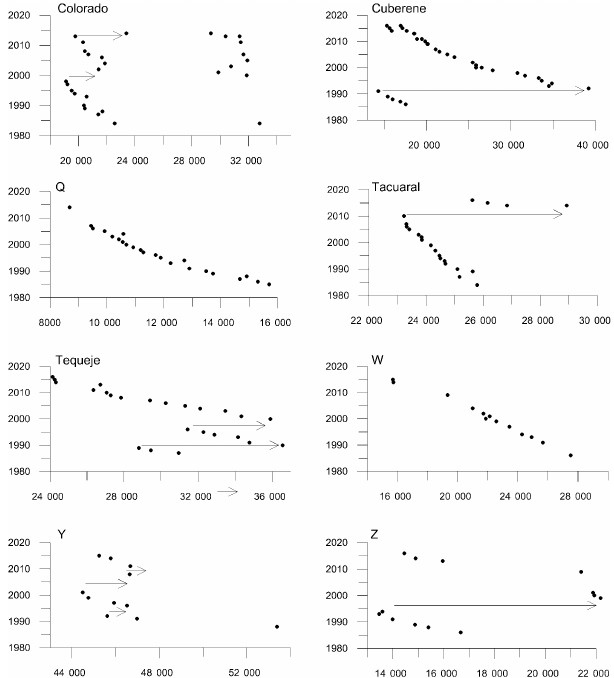
Figure 5. Locations of logjams in the eight rivers analyzed here. The year of logjam formation ( Y axis) is plotted against the logjam’s distance from the Andean piedmont in meters ( X axis). The arrows indicate river avulsions.